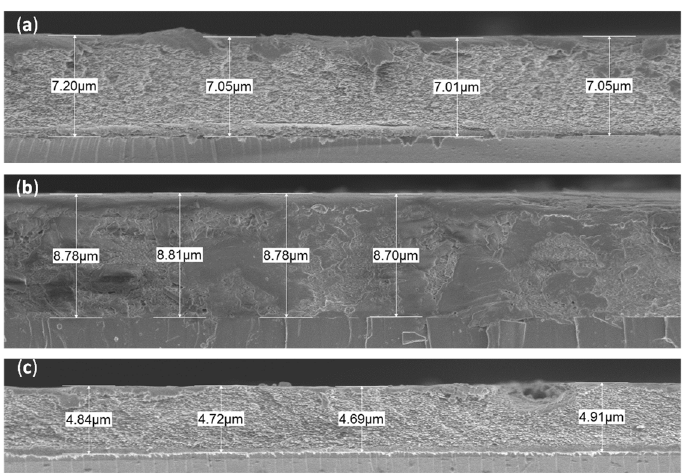
Figure A1. SEM cross-sectional images of films deposited ( a ) on day 1, ( b ) day 18, and ( c ) day 38.